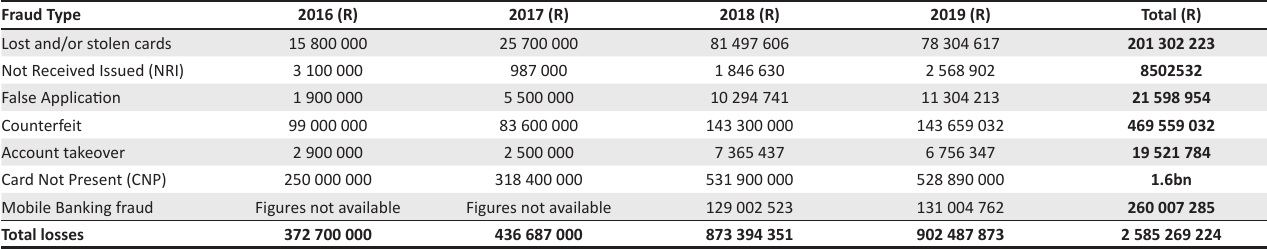
TABLE 1: Fraud statistics